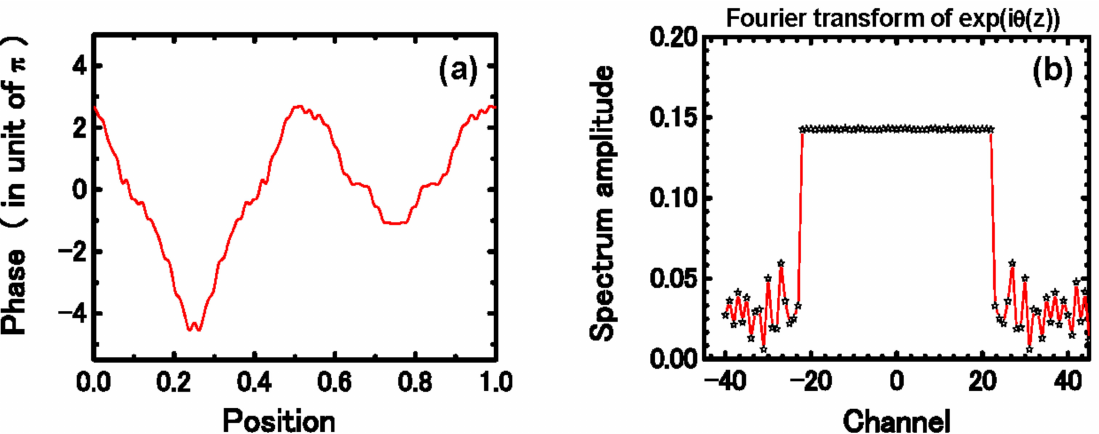
Figure 17. Design results for a continuous phase-only sampling function. ( a ) Phase distribution of the optimized 45-channel phase-only sampling function. ( b ) Fourier spectrum of the corresponding phase-only function. Adapted with permission from ref. [111]. © The Optical